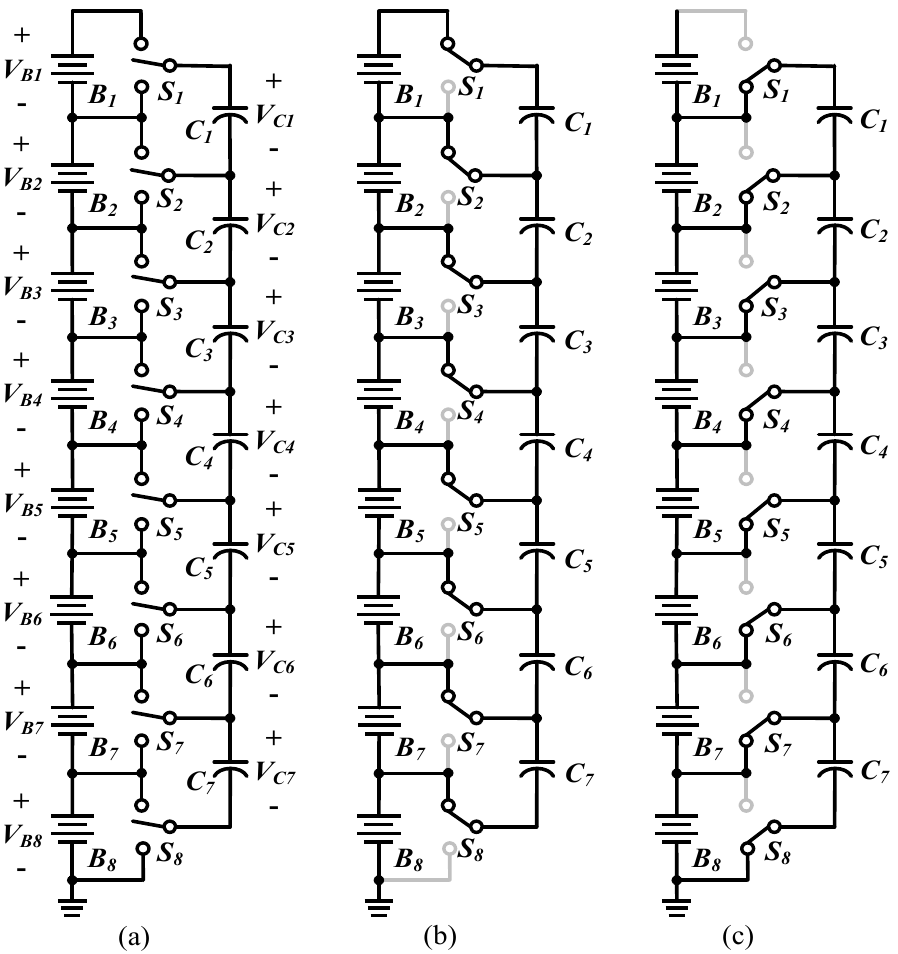
Figure 1. Conventional SC-based BE*: ( a ) circuit architecture; ( b ) first state; ( c ) second state. * Eight batteries are shown as examples.